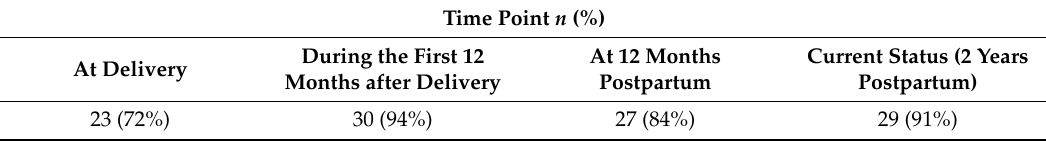
Table 2. Percentage self-reporting tobacco use among postpartum Alaska Native women ( n =